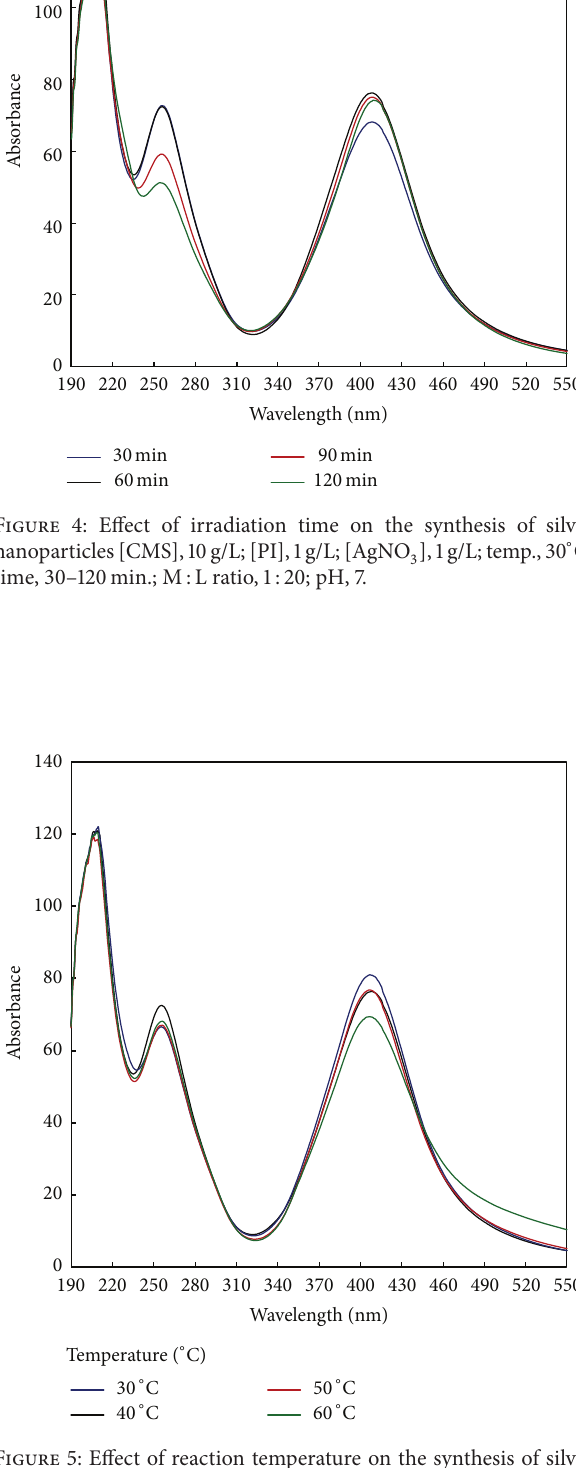
Figure 5: Effect of reaction temperature on the synthesis of silver nanoparticles [CMS], 10g/L; [PI], 1g/L; [AgNO 3 ], 1g/L; temp., 30– 60 ∘ C; time, 60 min.; M: L ratio, 1: 20; pH,